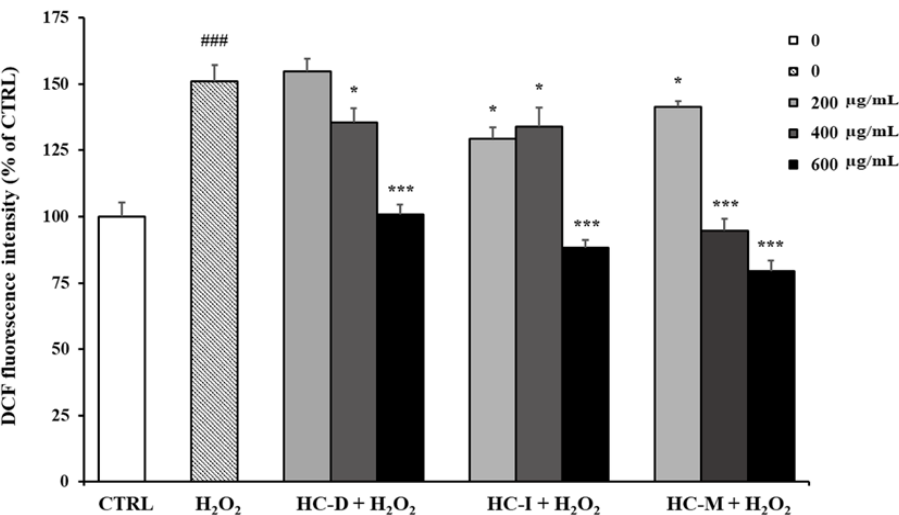
Figure 3. E ff ect of H. crepitans extracts on H 2 O 2 -induced intracellular ROS generation in HepG2 cells. The cells were pre-treated with the extracts at di ff erent concentrations (200, 400, and 600 µ g / mL) for 24 h and subsequently incubated for 1 h with 2 mM H 2 O 2 . ROS generation was measured by flow cytometry using DCFH-DA staining. Data are expressed as the mean ± SE of three independent experiments ( n = 3) and were analyzed by one-way ANOVA followed by Dunnett’s post-hoc test. ### p < 0.001 vs. CTRL, * p < 0.05 and *** p < 0.001 vs. H 2 O 2 -treated cells.